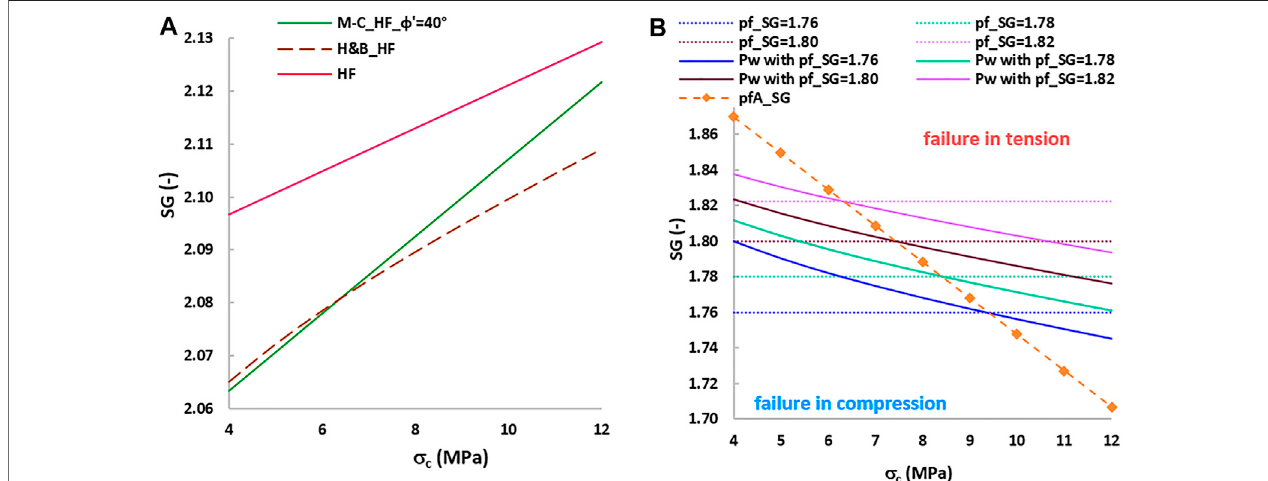
FIGURE 11 |(A) Variation ofthe limit mud weight (SG) with the uniaxial compressivestrength σ c = 4 – 12 MPa, ϕ ′ = 40 ° , m t = 10, and σ c / σ t ≈ 10. p f = 44.7 MPa. The red lineis the uniaxial tangential tensile failure HF calculated with σ ′ ϑ = S − P w − p f = − σ t and σ ′ r = 0. (B) Comparison between p fA _SG and the P w _SG calculated with Eq. 8 with the four overpressures p f _SG. σ c = 4 – 12 MPa, m t = 10, and σ c / σ t ≈